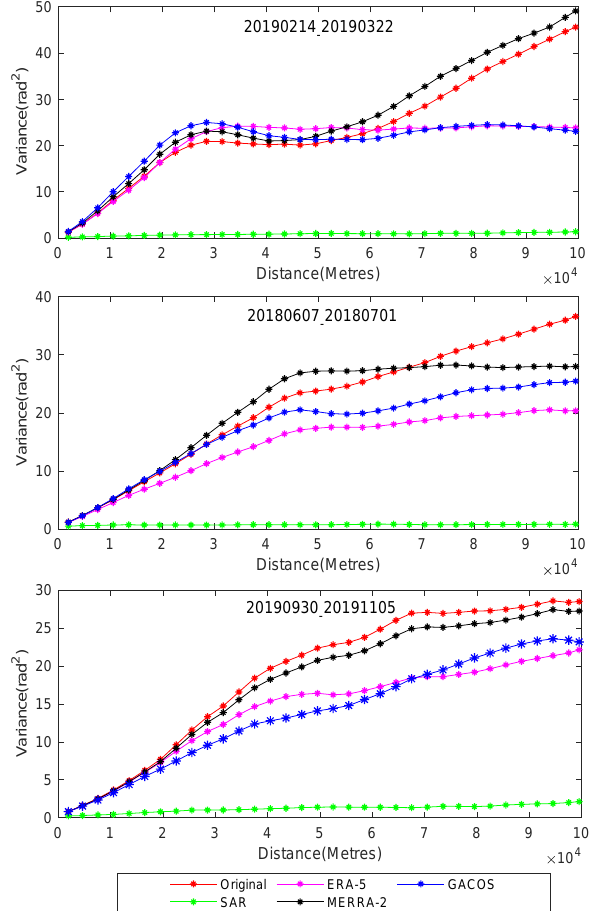
Figure 7. Evaluation of the tropospheric delay correction using experimental variograms showing spatial correlations before and after correction of short-interval interferograms using SAR-based and numerical weather model